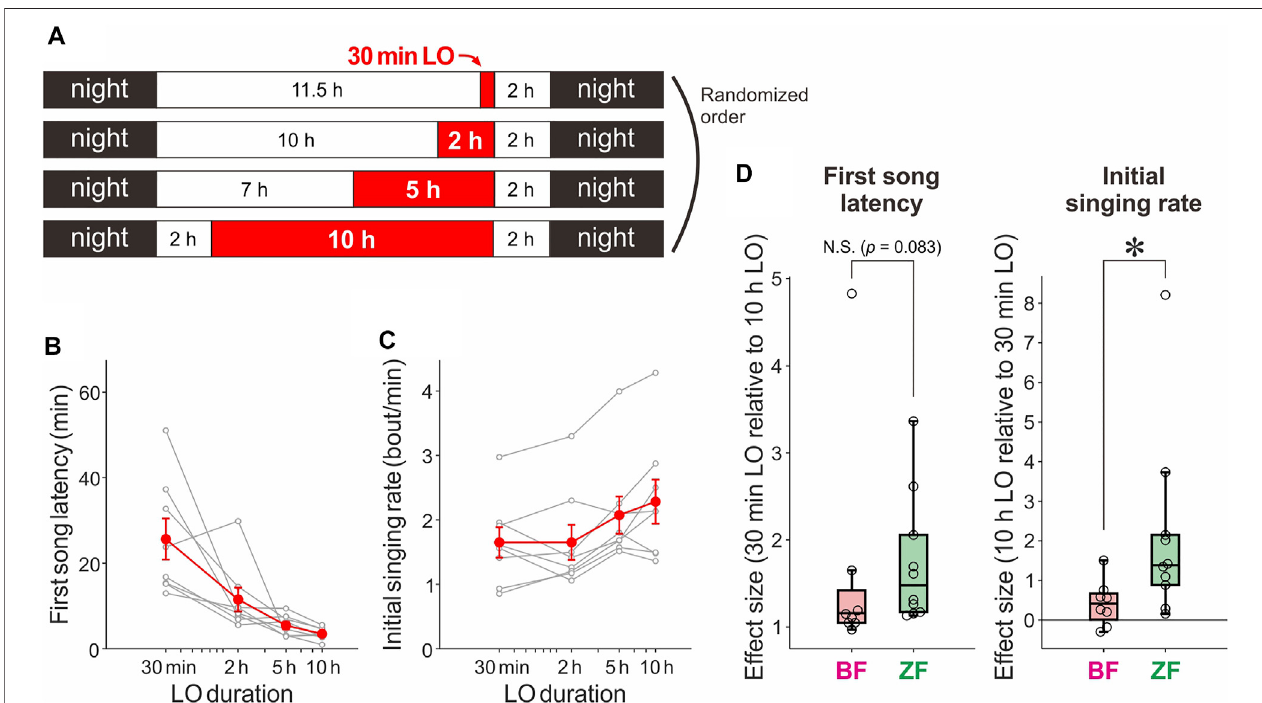
FIGURE2| EffectsofLOwith4differentdurations(30 min,2,5,and10 h)onsingingmotivationinBFsandtheircomparisonwiththoseinZFs. (A) Dailyscheduleof LO periods (red areas) with four different durations. On each day, a single LO period with one of the four different durations was given with the offset at 2 h before night; theonsetwasvarieddependingontheLOduration.BirdsreceivedLOperiodswithfourdifferentdurationsinarandomizedorder. (B) Firstsonglatenciesplottedagainst LO durations in BFs ( n = 8 birds). Gray lines indicate data for individual birds and red lines represent mean ± SEM across all birds. (C) Initial singing rates plotted againstLOdurationinBFs( n =8birds).ConventionsaresameasinB. (D) Theeffectsizesforthe fi rstsonglatency(left)andtheinitialsingingrate(right)betweena30 min and 10 h LO in BFs and ZFs * p <